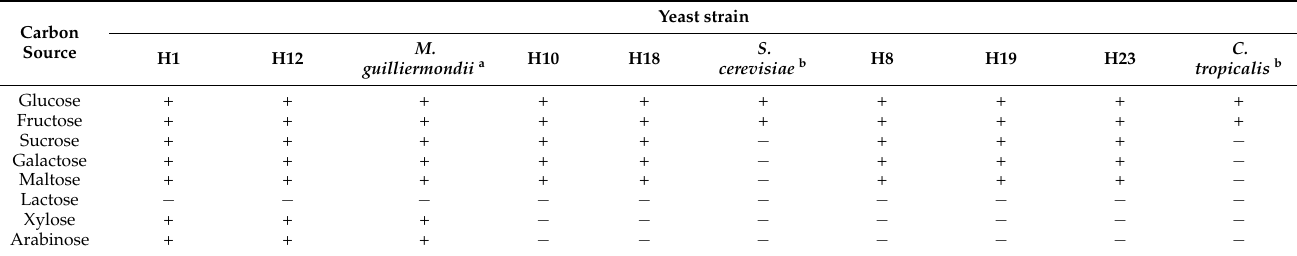
Table 2. Carbon fermentation assays of the isolated yeasts using the Durham